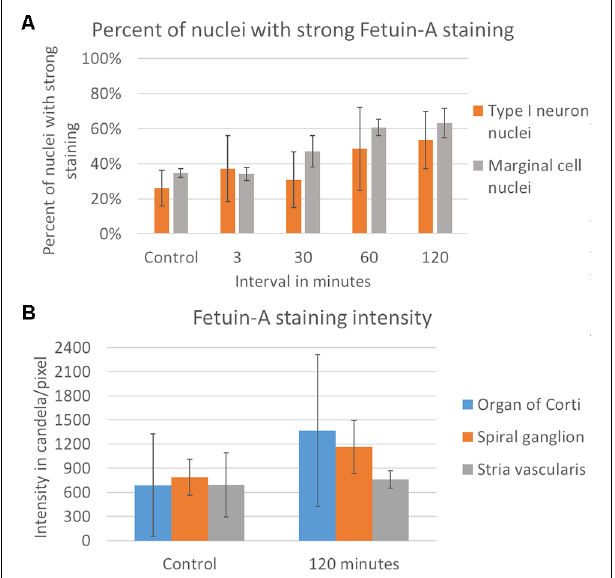
FIGURE 4 | Rating of Fetuin-A nuclei staining and densitometry. (A) Rating of Fetuin-A staining intensity in type I neuron nuclei (orange) and marginal cell nuclei (gray). Result presented as the mean value of each group, with error bars showing standard deviation. (B) Densitometry of Fetuin-A staining intensity. Result presented as mean value of the control and 120 min group, with error bars showing standard deviation. Intensity increased in the organ of Corti (blue) and the spiral ganglion (orange), with no change in the stria vascularis (gray). causes a rapid reduction in the endocochlear potential